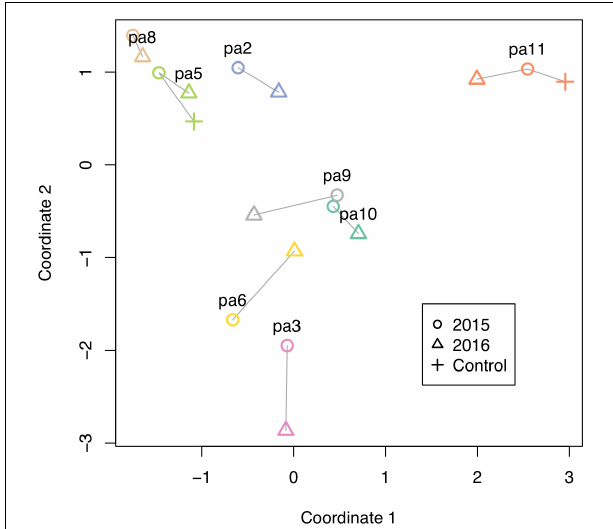
FIGURE 5 | Methylation changes from 2015 to 2016. Multidimensional scaling plot of methylation. Individual colonies are shown with different colors, and vectors show relative direction and magnitude of change from 2015 to 2016, including two controls that were left at their site of origin.